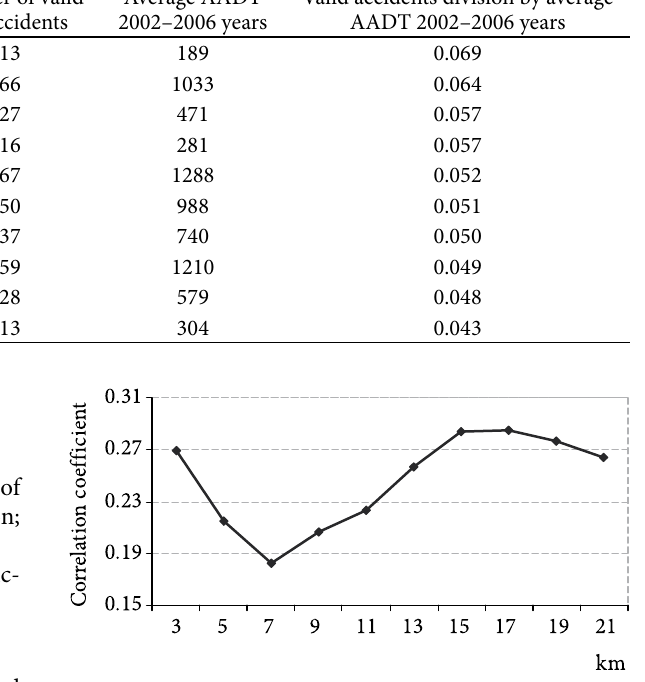
Fig. 3. Correlation between traffic accidents and population in an area